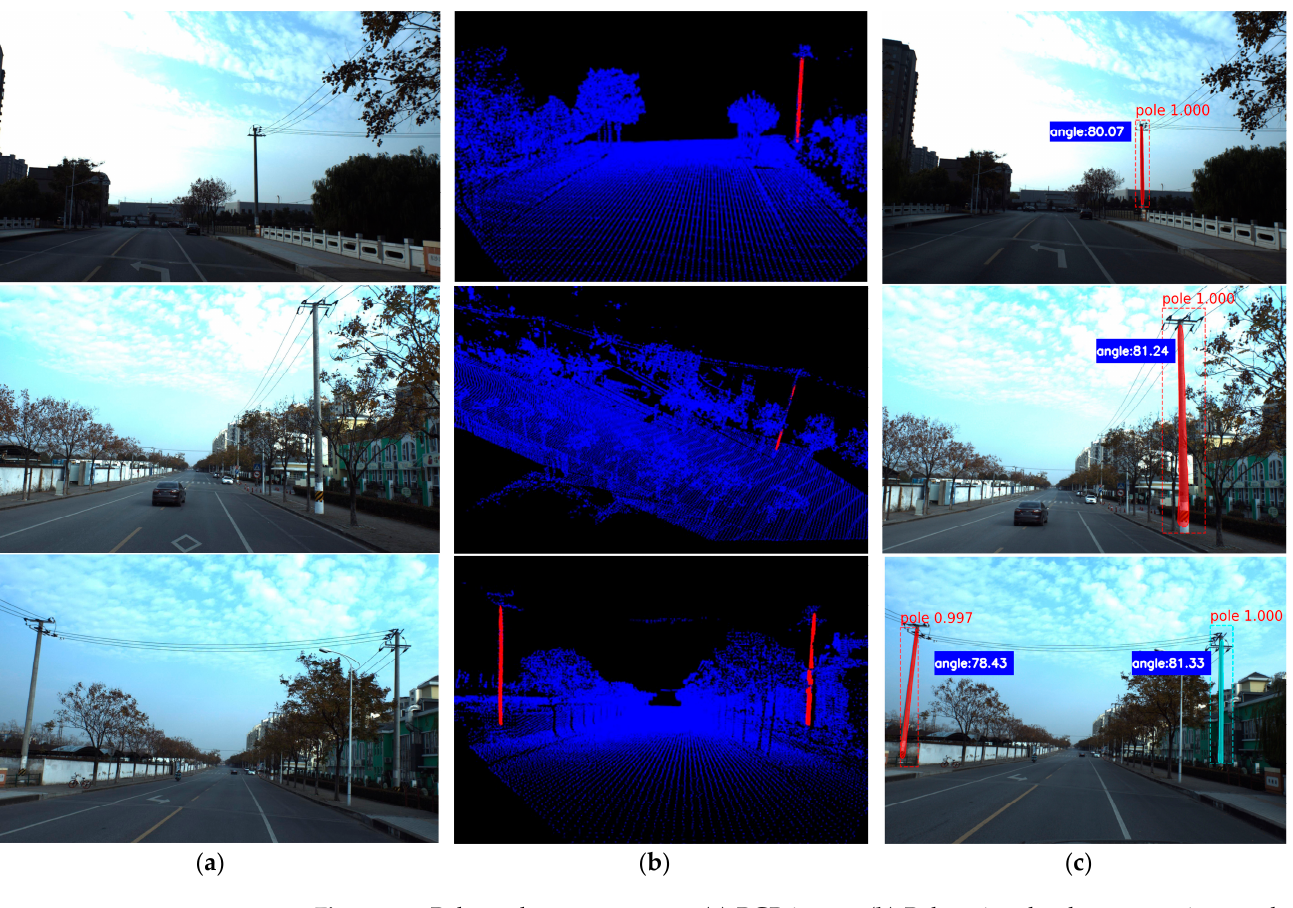
Figure 17. Pole angle measurement. ( a ) RGB image; ( b ) Pole point cloud segmentation results; ( c ) Measurement results in the camera coordinate system.